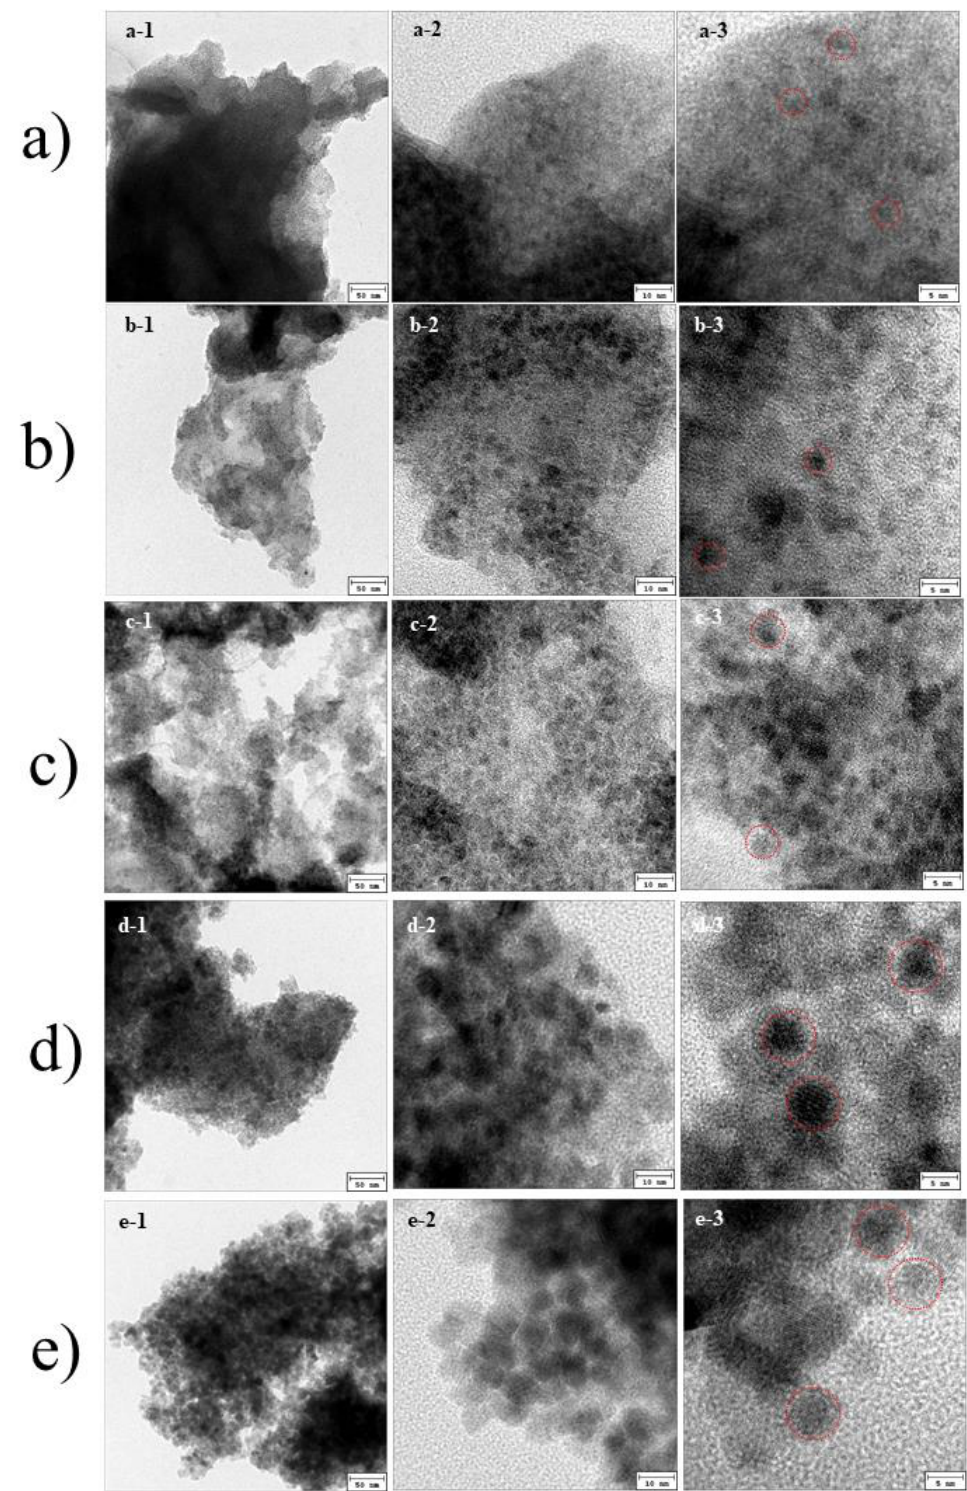
Figure 1. Transmission electron microscopy (TEM) images of ( a ) sample #1; ( b ) sample #2; ( c ) sample #3; ( d ) sample #4; and ( e ) sample #5. The crystalline sizes of the Fe 3 O 4 nanoparticles (NPs) are shown within the dotted red circles.